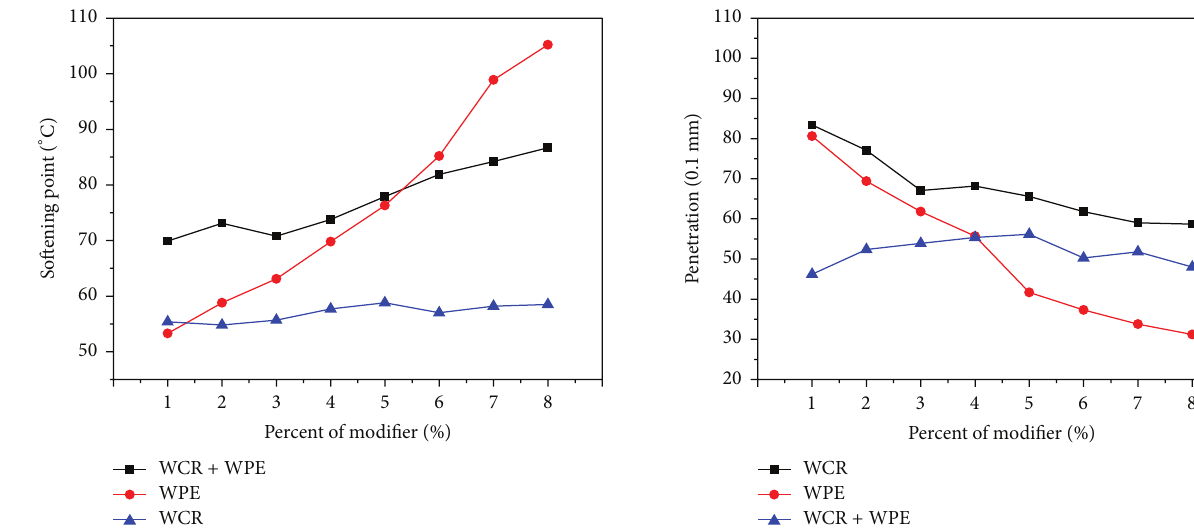
Figure 1: The softening point of modified asphalt.